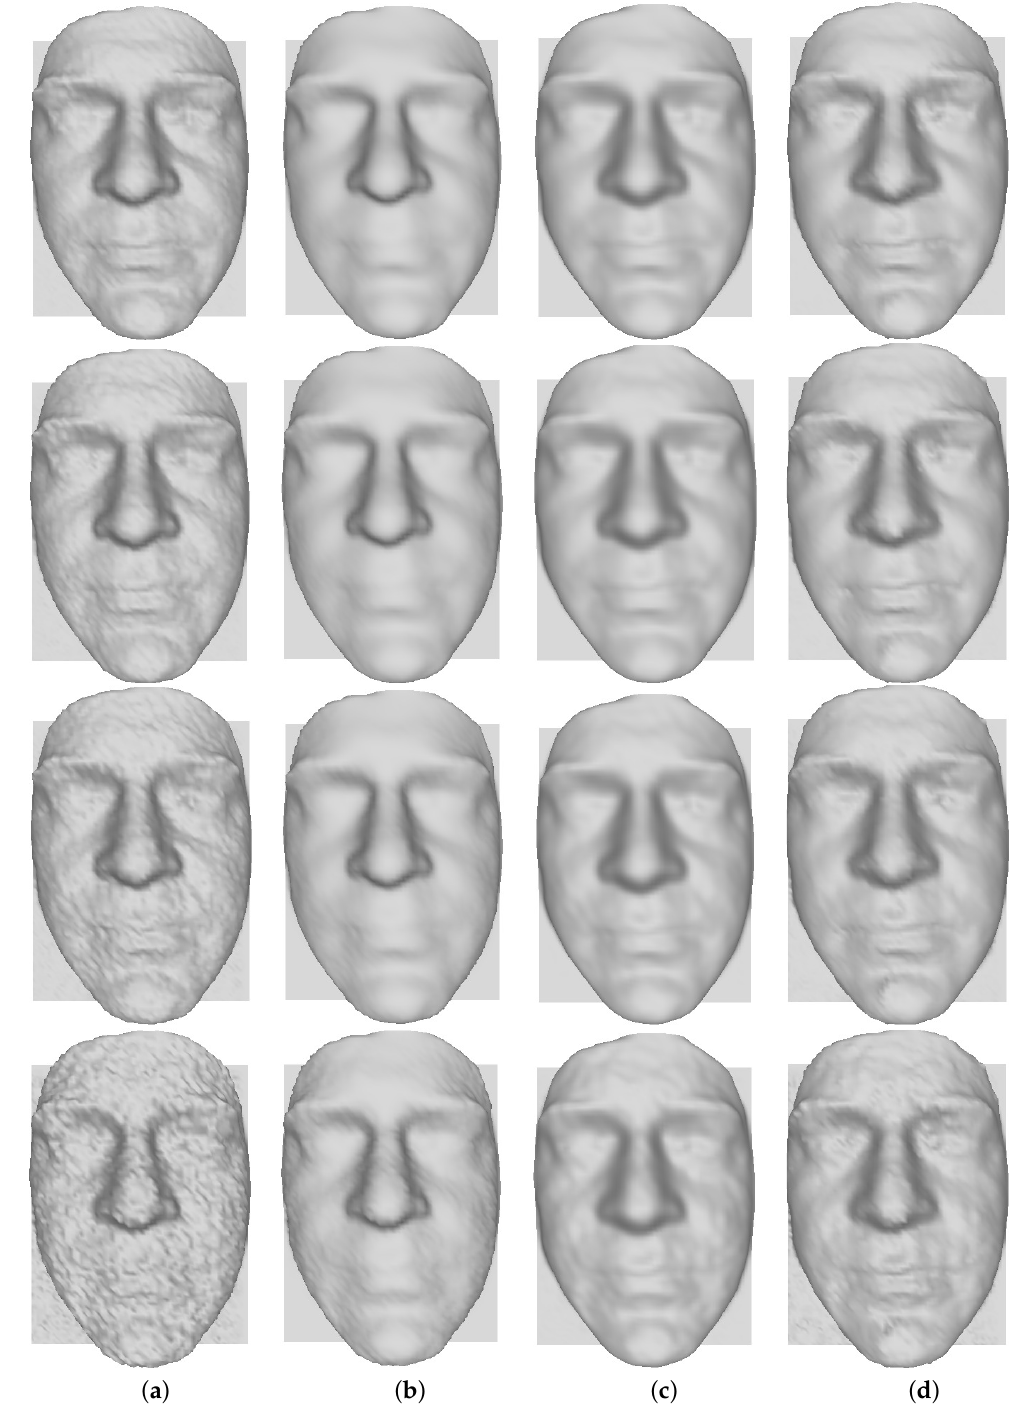
Figure 16. The results obtained by the tested filters. Each row shows the noise levels applied to the models, which are 0.5, 0.7, 1.0 and 2.0 (respectively) multiplied by standard deviation. Column ( a ) illustrates the noisy model, while columns ( b – d ) show models filtered by the Bilateral and Gaussian filters and our filter,